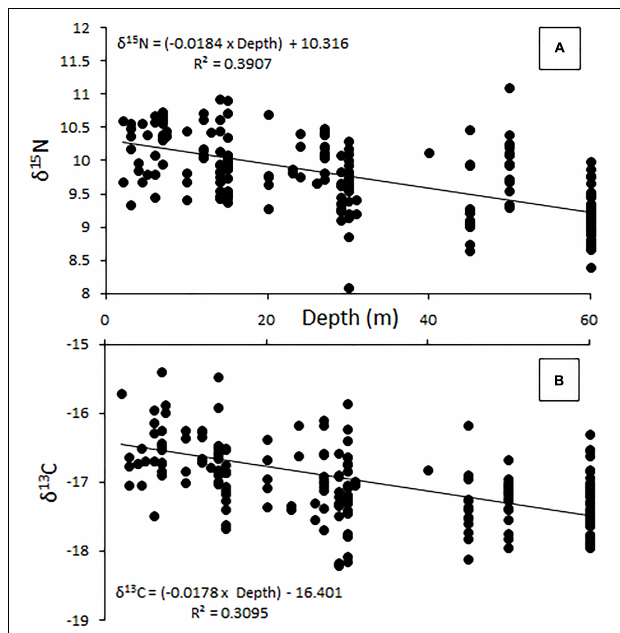
FIGURE 4 | Change in δ 15 N (A) and δ 13 C (B) with increasing depth (m), showing a general decrease in both measures as depth increases. This relationship is not significant [ANOVA, F(1,215) = 3.88, p > 0.05].